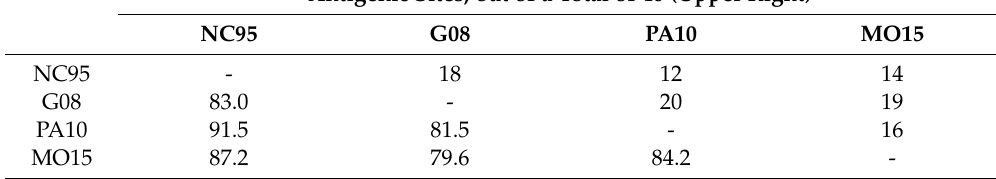
Table 1. Genetic relationships between the HA1 of the strains used for immunization. Percentage Amino Acid (aa) Identities (Lower Left) and Number of Di ff erent aa at Antigenic Sites, out of a Total of 40 (Upper Right) NC95 G08 PA10 MO15 NC95 - 18 12 14 G08 83.0 - 20 19 PA10 91.5 81.5 - 16 MO15 87.2 79.6 84.2 - NC95; A / Nanchang / 95, G08; A / swine / Gent / 172 / 2008, PA10; A / swine / Pennsylvania / A01076777 / 2010, MO15; A / swine / A01840724 / 2015, -; not applicable, HA1; Hemagglutinin